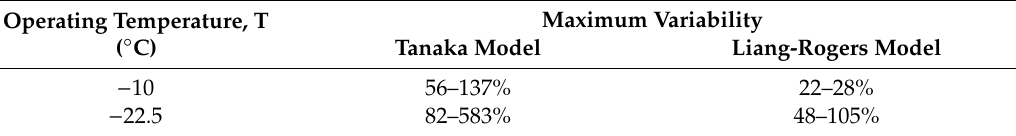
Figure 2. Parallel coordinate plot showing the upper and lower limits of the input parameters (the limits are shown for the temperature − 10 ◦ C). Table 4. Maximum strain variability.